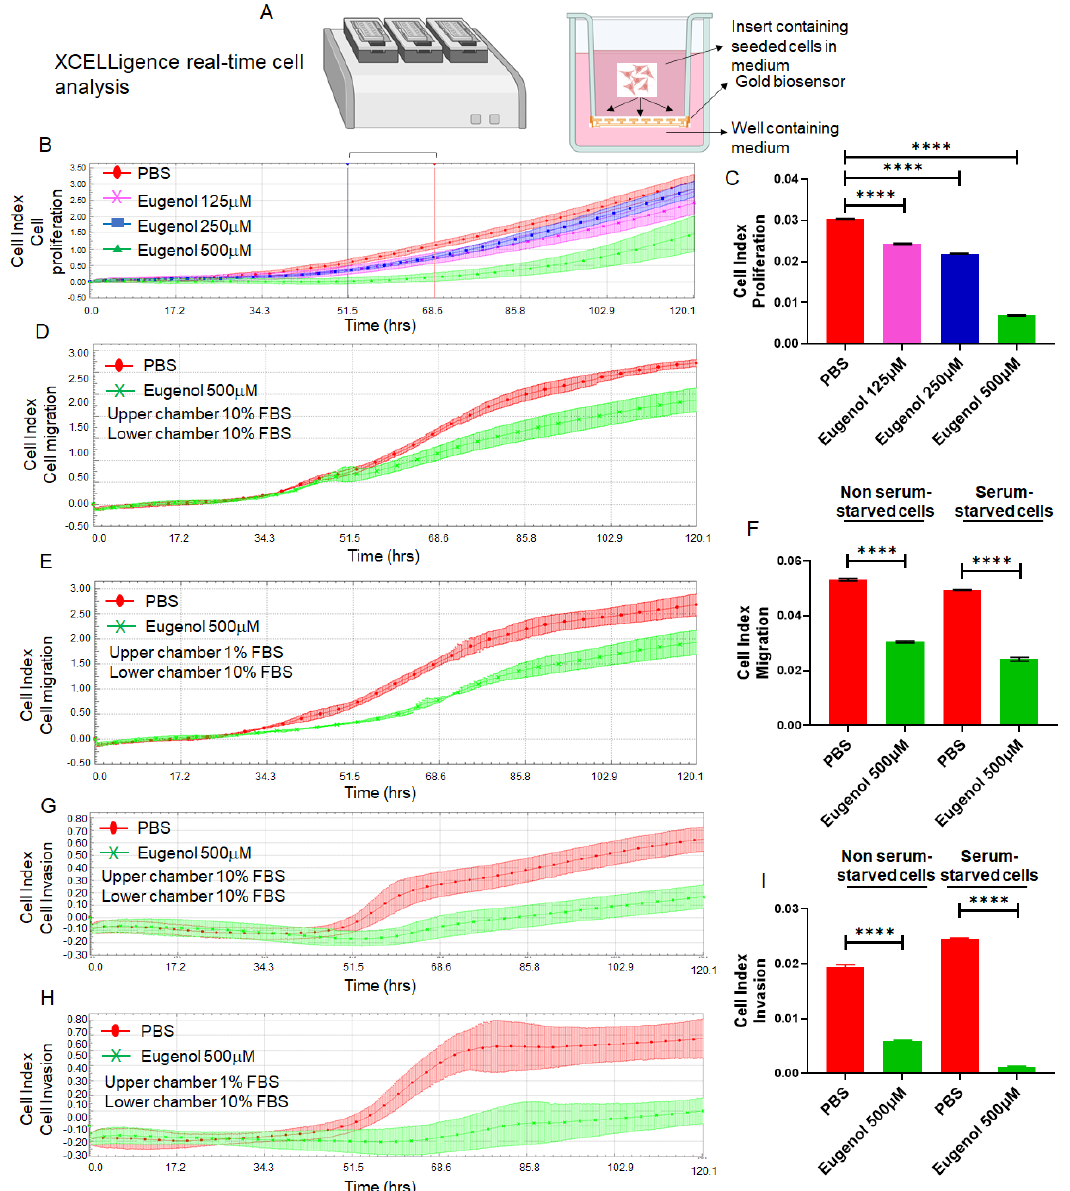
Figure 4. EUG significantly reduces cell adhesion, cell migration, and invasion in human colon cancer cells. Panel ( A ): The xCELLigence RTCA technology is an accurate platform for non-invasive measurement of cell adhesion/viability and migration/invasion in live cells. HCT-116 cells were monitored in real-time for cell adhesion, migration, and invasion for 120 h in the presence of EUG. Graphs (panels ( B , D , E , G , H )) and statistical analysis of calculated slopes (panels ( C , F , I )) using critical time points between 50 h and 70 h post-treatment (Blue and red lines in panel ( B )) show that EUG significantly suppressed cancer cell adhesion, migration, and invasion. Experiments carried out in both the absence and presence of serum starvation (Panels ( F , I )) had no effect on EUG’s suppressive effects, indicating that EUG targets key signaling pathways involved in migration and invasion. The blue (50 h timeline) and red (70 h timeline) in panel ( B ) show critical time points used for analyzing the cell indexes recorded in adhesion, migration, and invasion assays in live cells. Experiments were repeated two times with N of 4 per cell line per experiment (**** p < 0.0001, mean ± SD).